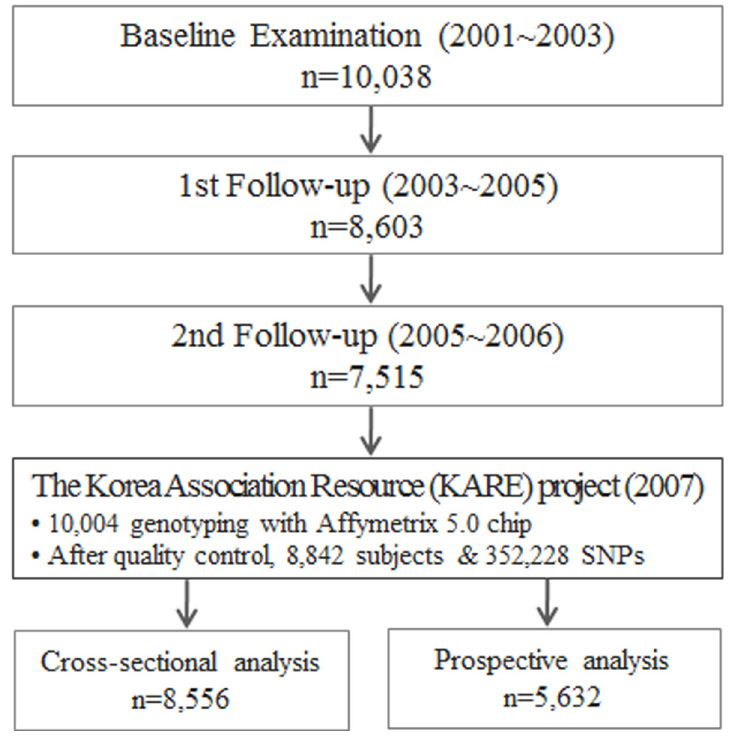
Fig 1. Study flow chart and analysis sets from the KoGES and KARE